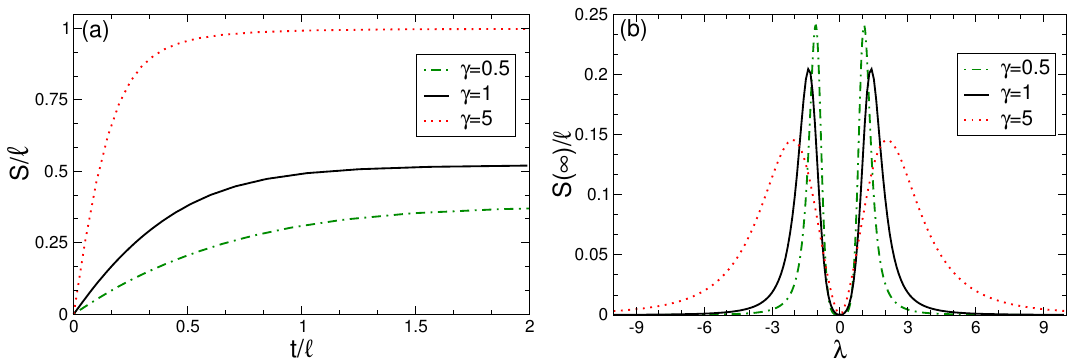
Figure 11: Entanglement entropy dynamics in the repulsive Lieb-Liniger model after the quench from the Bose condensate (BEC). (a) Quasiparticle picture prediction for S /(cid:96) plotted versus the rescaled time t /(cid:96) . The different curves correspond to different values of the inter- action strength γ . Notice the absence of the linear regime at short times. (b). Contributions of the quasiparticles of rapidity λ to the stationary entanglement. The different curves are for different values of γ (same as in (a)).